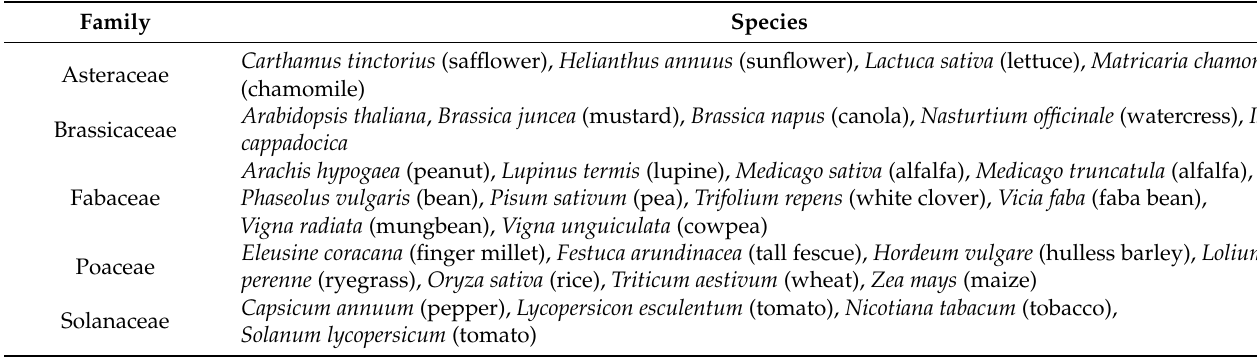
Table 1. Species and plant families included in the meta-analysis.